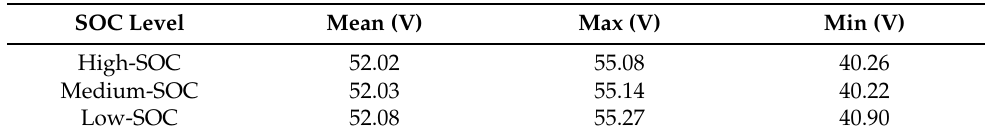
Table 11. DC bus’s controlled voltage response in high, medium, and low SOC full-active hybrid simulation.